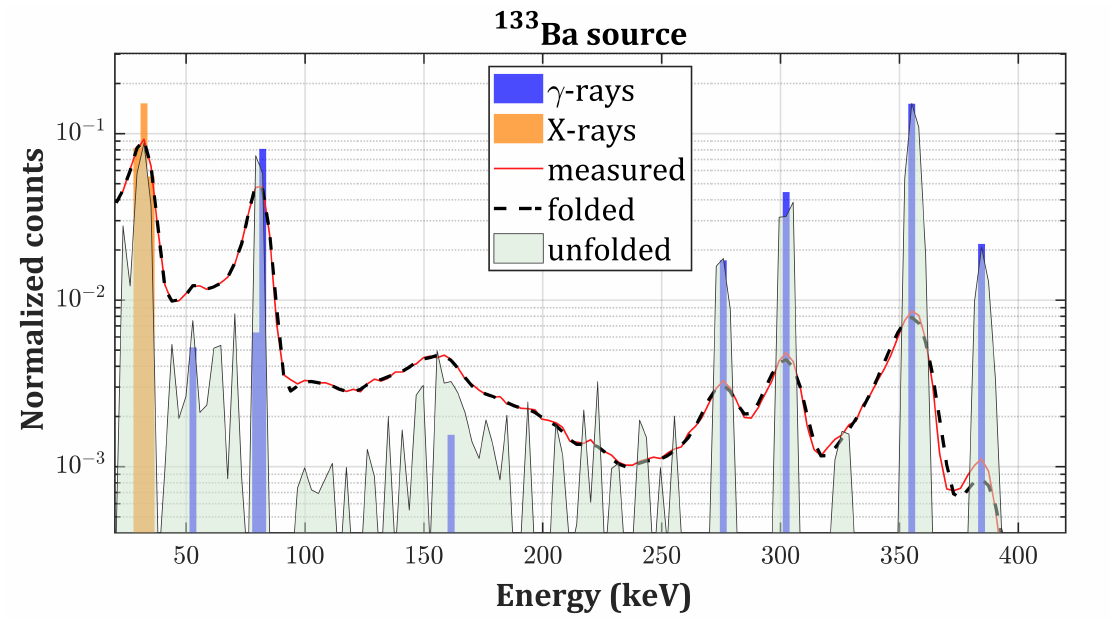
Figure 6. 133 Ba unfolded spectrum (gray curve) compared to the measured spectrum (red curve), the folded spectrum (black dashed curve) and the tabulated intensities of the γ -emissions (blue bars) and X -emissions (orange bars) of 133 Ba on a logarithmic